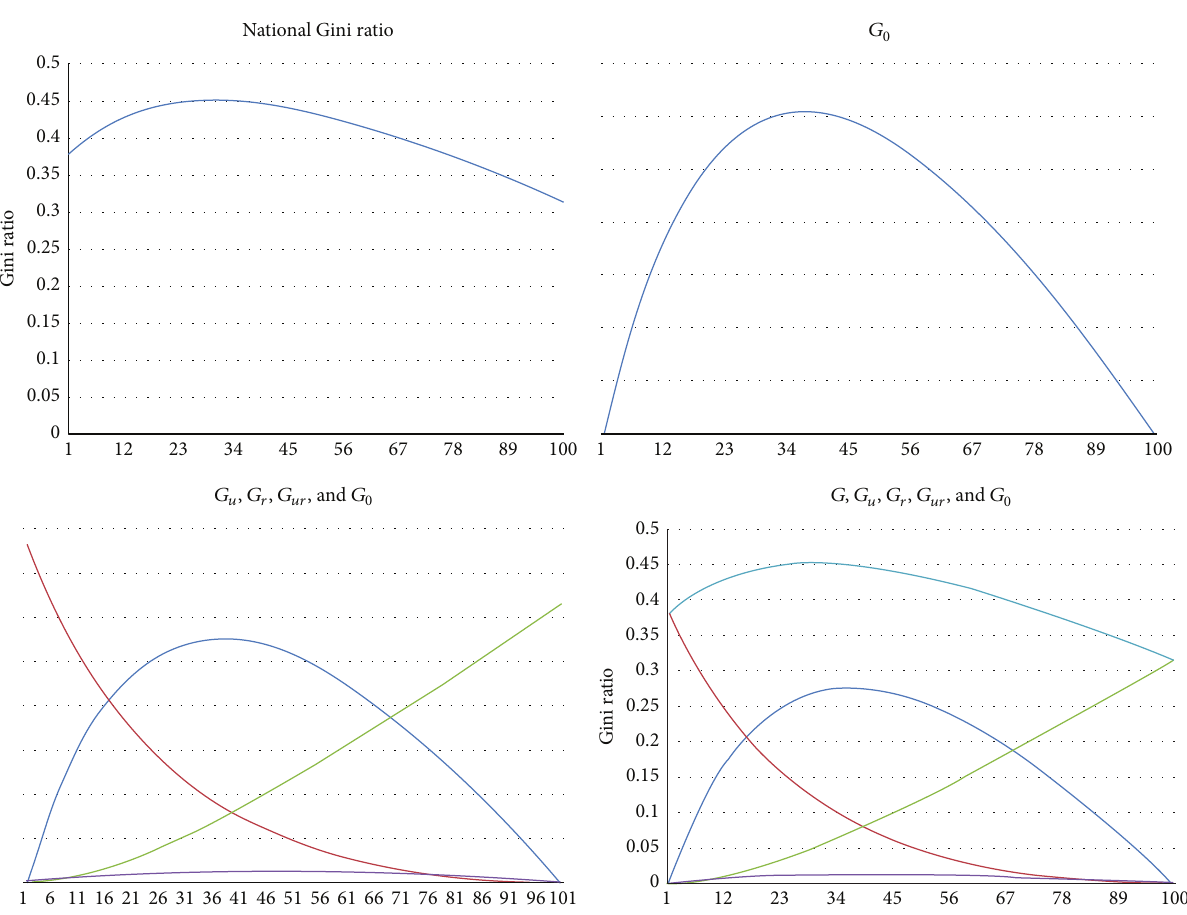
(the 𝐼 𝑟 𝑃 𝑟 𝐺 𝑟 curve steadily declines to the bottom right), the income inequality in urban areas (the 𝐼 𝑢 𝑃 𝑢 𝐺 𝑢 , curve steadily rises to the upper right), the income difference between urban and rural areas ( 𝐺 𝑢𝑟 is the inverted 𝑈 curve), and 𝐺 0 (the inverted curve close to the 𝑋 axis). The bottom right one is a combination of the upper left and bottom left